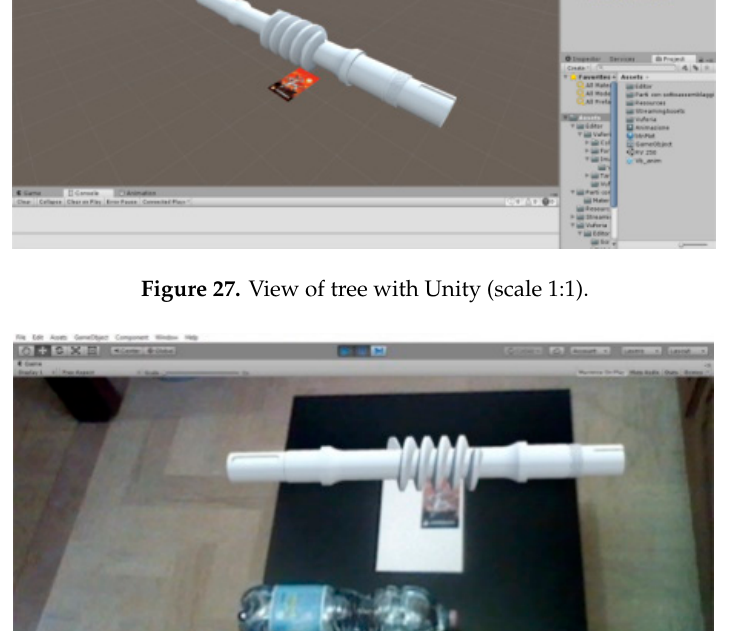
Figure 29. View of the gearbox with Unity (scale 1:1).